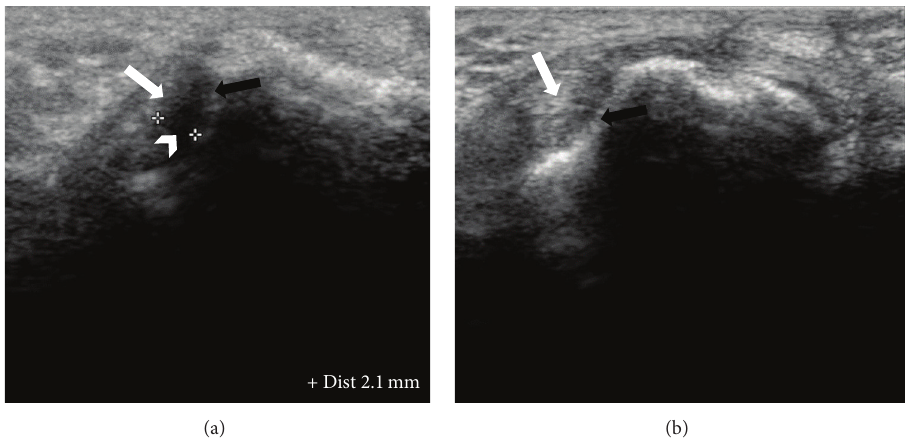
Figure 2: Dorsal ultrasound images of MCPJ at bare areas. (a) Radial recess shows distinct hypoechoic synovium ( arrow head ) compared to displaced hyperechoic proper collateral ligament ( white arrow ) and bone ( black arrow ). Calipers are being used to measure the maximal synovial thickness at this region with characteristic appearance on ultrasound. (b) shows no synovial thickening between the proper collateral ligament (white arrow) and adjacent to cortical bone ( black arrow ).